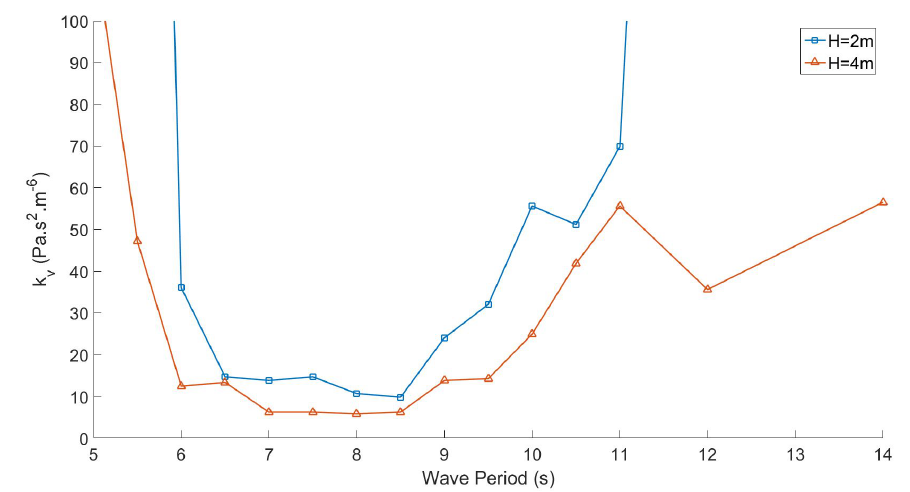
Figure 14. HP valve damping coefficient in regular waves (full-scale